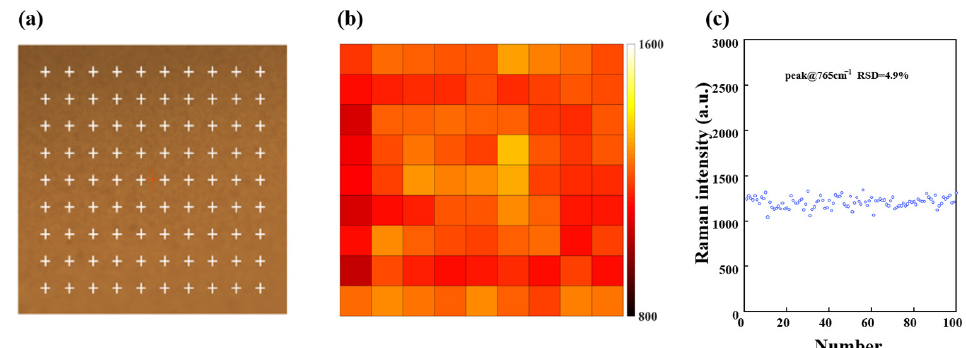
Figure 6. ( a ) The scanning area (50 × 50 µ m 2 ) of the Au–Ag composite structure covered by R6G molecule, the cross sign indicates the detection point. ( b ) SERS intensity mapping at 765 cm − 1 . ( c ) The Raman intensity distribution at the 765 cm − 1